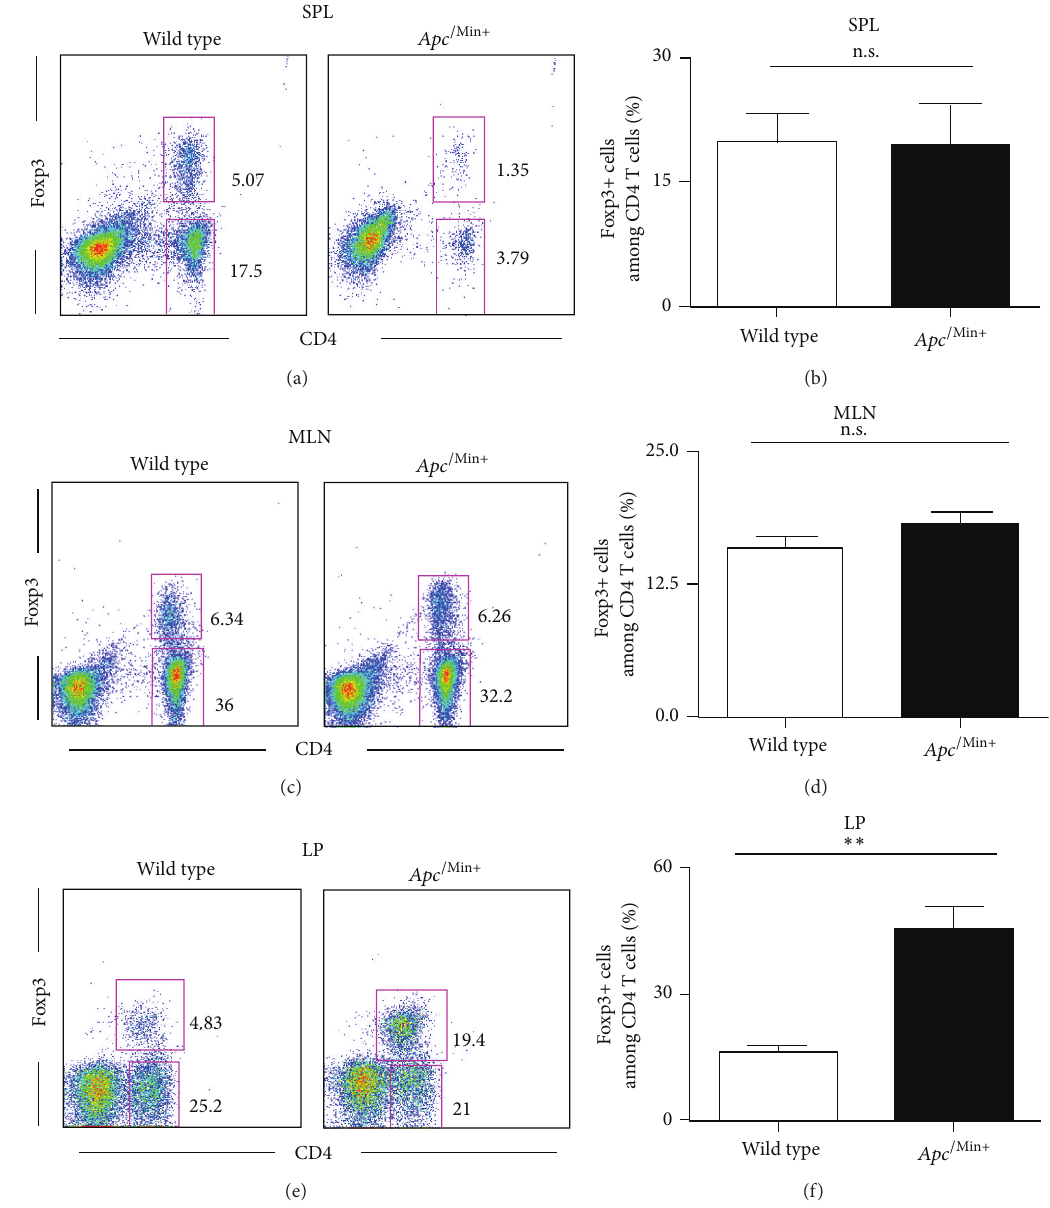
Figure 1: Regulatory T cells are selectively expanded and altered in the lamina propria of 𝐴𝑝𝑐 / Min + mice. (a–d) Four-month-old 𝐴𝑝𝑐 Min /+